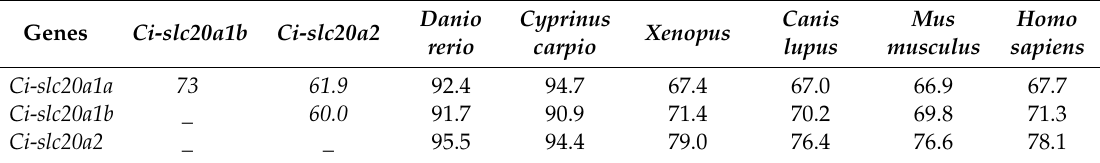
Table 2. Amino acid sequence identities of SLC20s between grass carp C. Idella (Ci) and other species (%).